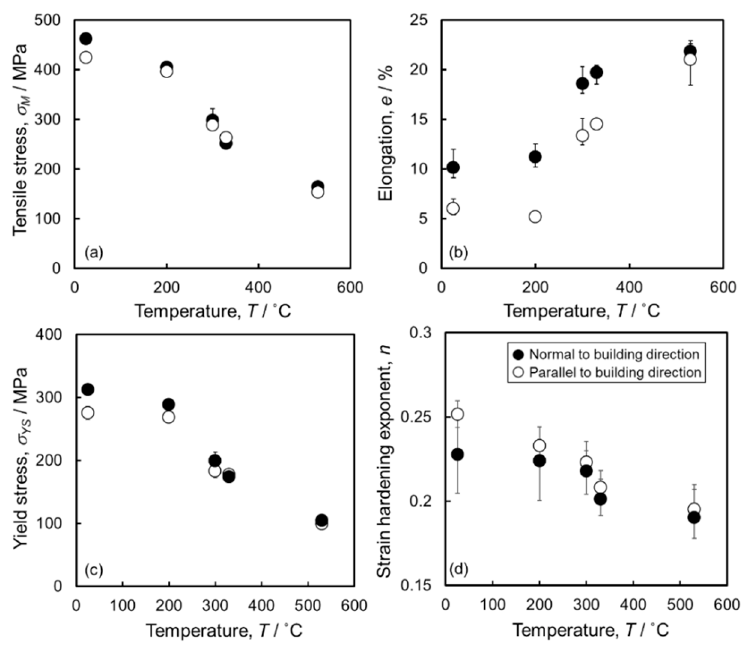
Figure 11. Changes in ( a ) maximum tensile stress, ( b ) total elongation, ( c ) 0.2% proof stress (yield stress) and ( d ) strain hardening exponent of the LPBF-fabricated specimens with annealing temperature. Table 2. Mechanical properties of LPBF-fabricated Al-12Si alloy annealed at various temperatures. Tensile Tensile Stress Anisotropy in Elongation Anisotropy in Direction ( σ M / MPa) Stress (%) ( e / %) Elongation